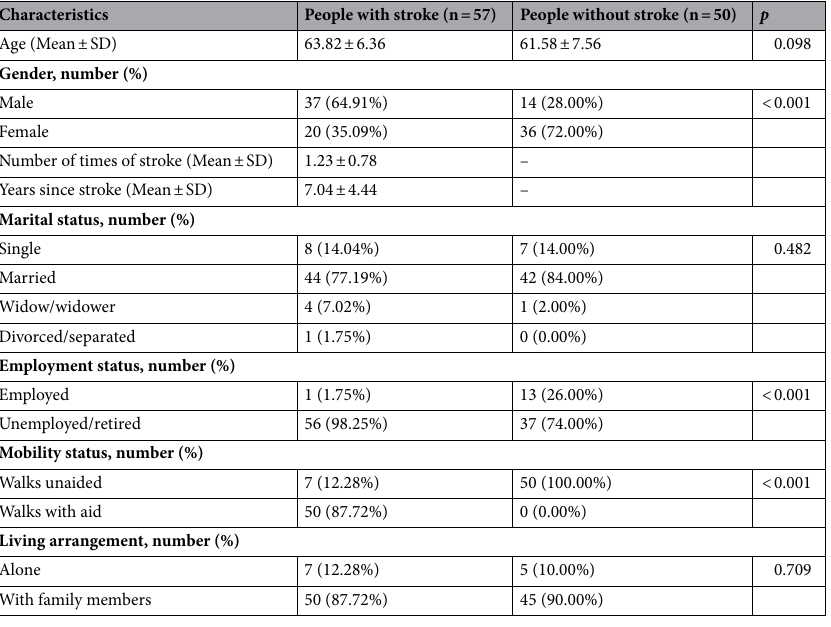
Table 1. Demographics characteristics of the participants. SD standard